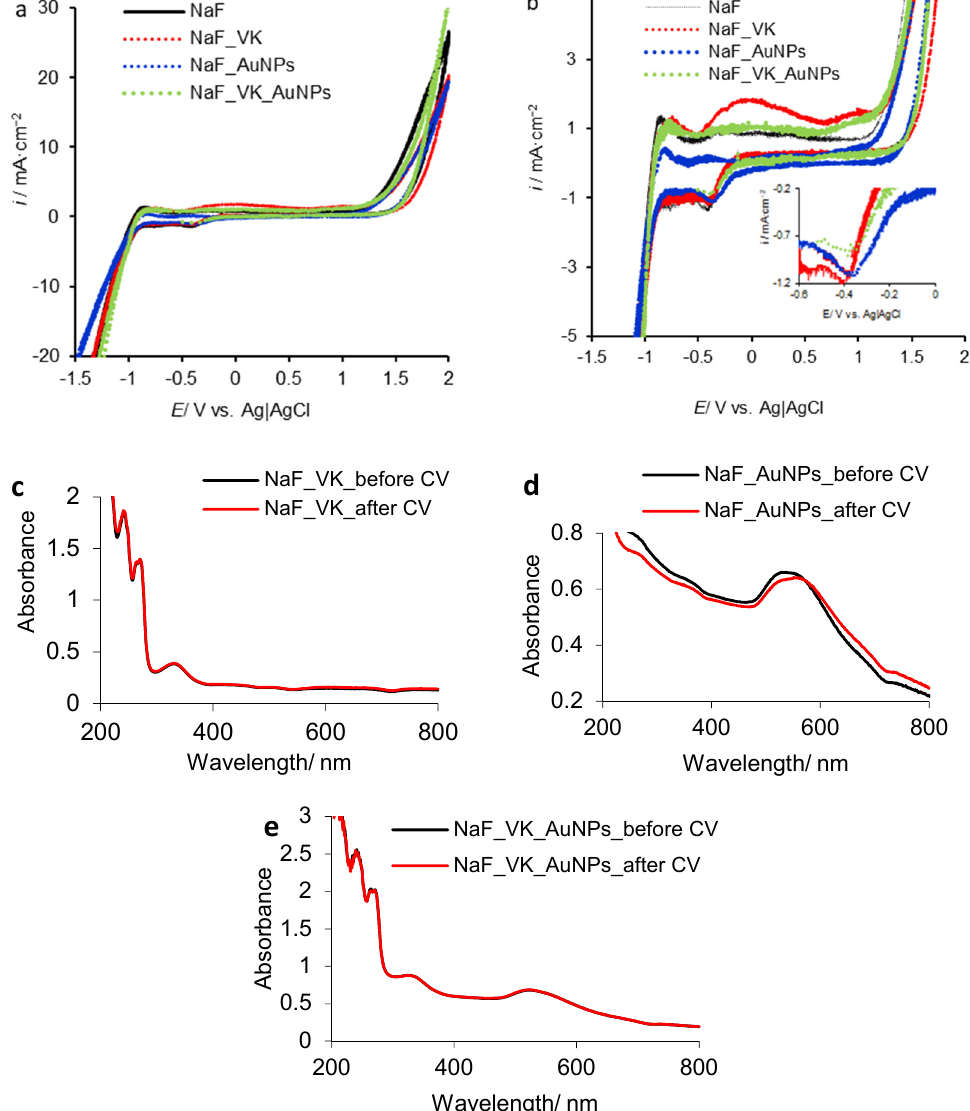
Figure 3. Cyclic voltammograms recorded on platinum electrode in 0.1 mol · L − 1 NaF blank solution and 0.1 mol · L − 1 NaF solution containing 6.65 × 10 − 5 mol · L − 1 VK, in the absence and presence of 75 mg · L − 1 AuNPs ( a ) and their details for low current densities ( b ); UV-Vis spectra collected before and after CV; ( c )—in NaF solution containing VK (NaF–VK); ( d )—in NaF solution containing AuNPs (NaF–AuNPs); ( e )—in NaF solution containing VK and AuNPs (NaF–VK–AuNPs).